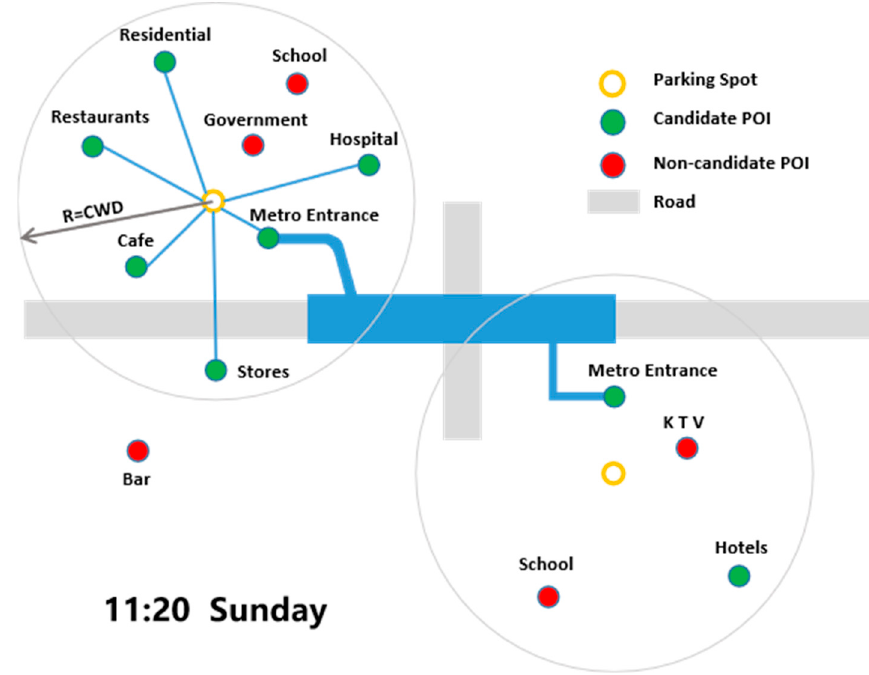
Figure 3. Schematic diagram of candidate POI